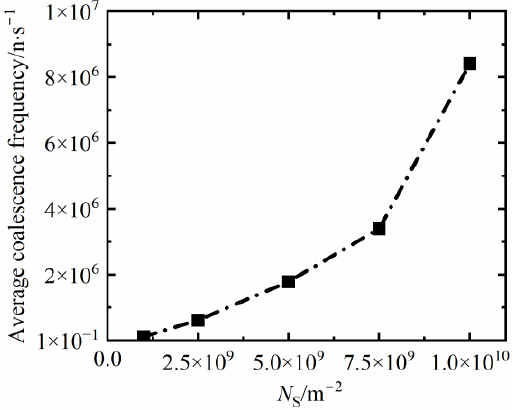
Figure 16. Comparison of coalescence frequency under different nucleus densities.